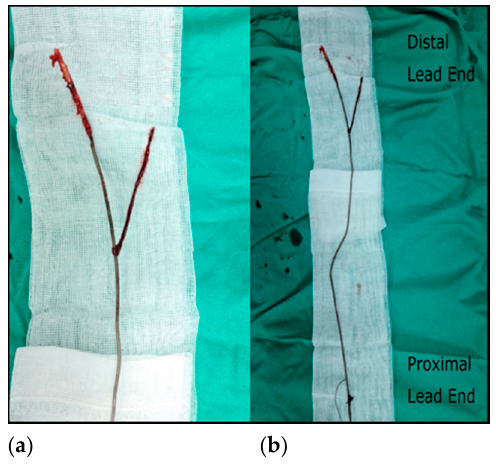
Figure 6. Extracted lead: ( a , b ) fibrotic capsule that encased the lead along the distal end and distal region of the lead and large pedunculate vegetation attached (approximately 38/6 mm).